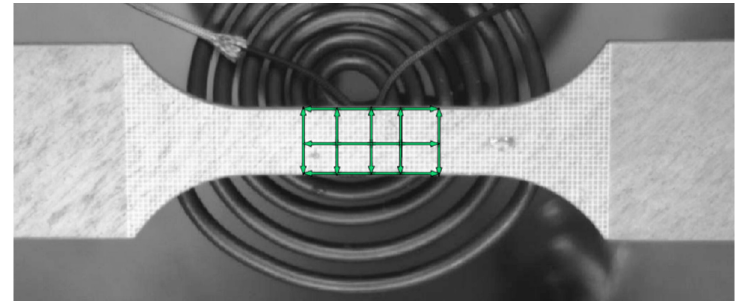
Figure 3. Virtual extensometer over measuring range (20 × 10 mm), GOM Correlate.